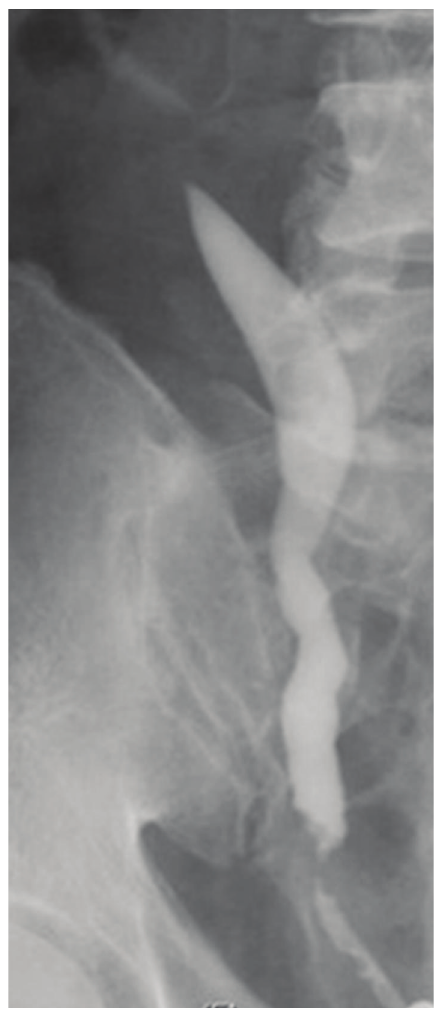
Figure 1: Retrograde pyelography showing an obstruction of the lower part of the right ureter.